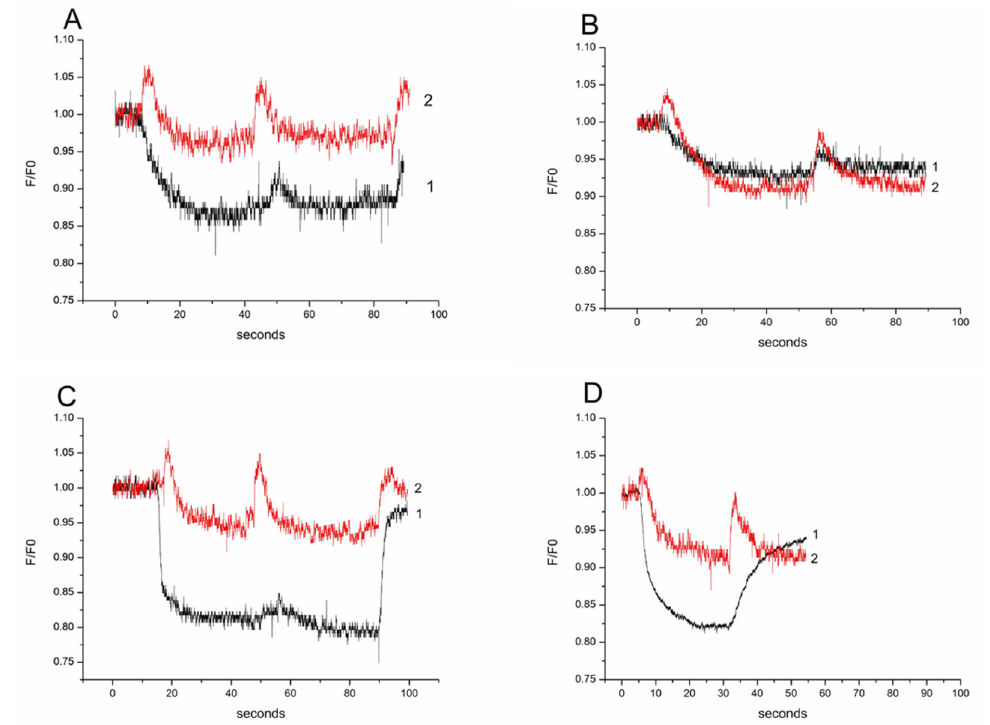
Figure 4. Effect of isotonic gradients (100 mM) of myo-inositol and urea on the cell intracellular calcium. Synchronized profiles for Calcein (black plot-1 demonstrating cell volume) and Fluo4 (red plot-2 demonstrating [Ca 2+ ] i ) in rat primary mesothelial cell experiments with ( A ) myo-inositol and ( B ) urea. Synchronized profiles for Calcein and Fluo4 in rat primary outer medullary collecting duct principal cells in experiments with ( C ) myo-inositol and ( D ) urea.